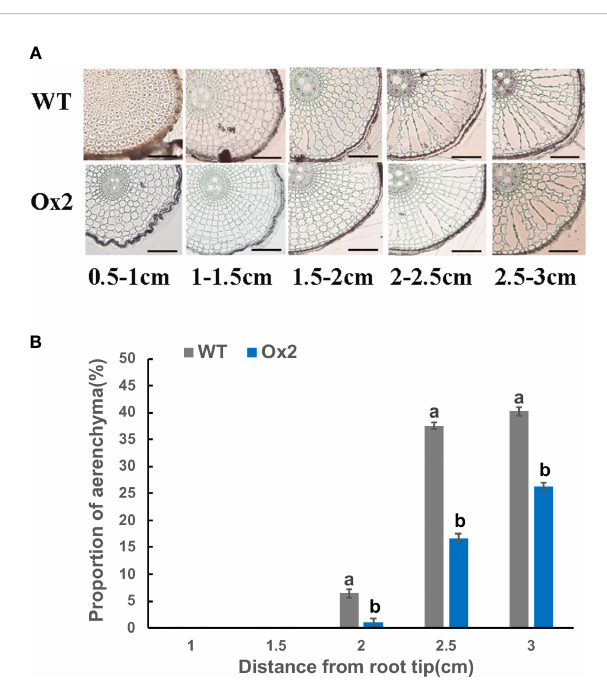
FIGURE 5 Describe aerenchyma formation in rice roots of WT and O8. Figures (A, B) show resin sections results of roots and aerenchyma formation (%) 0-0.5 cm, 0.5-1.0 cm, 1.0 – 1.5 cm, 1.5 – 2.0 cm and 2.0-2.5 cm from root apex in WT and O8 and signi fi cant difference between WT and O8 in each group are indicated by different letters: a= high value, b= lower value. Aerenchyma pics scale bar: 200um, Error bars: SE (n = 3) ( t -test, p<